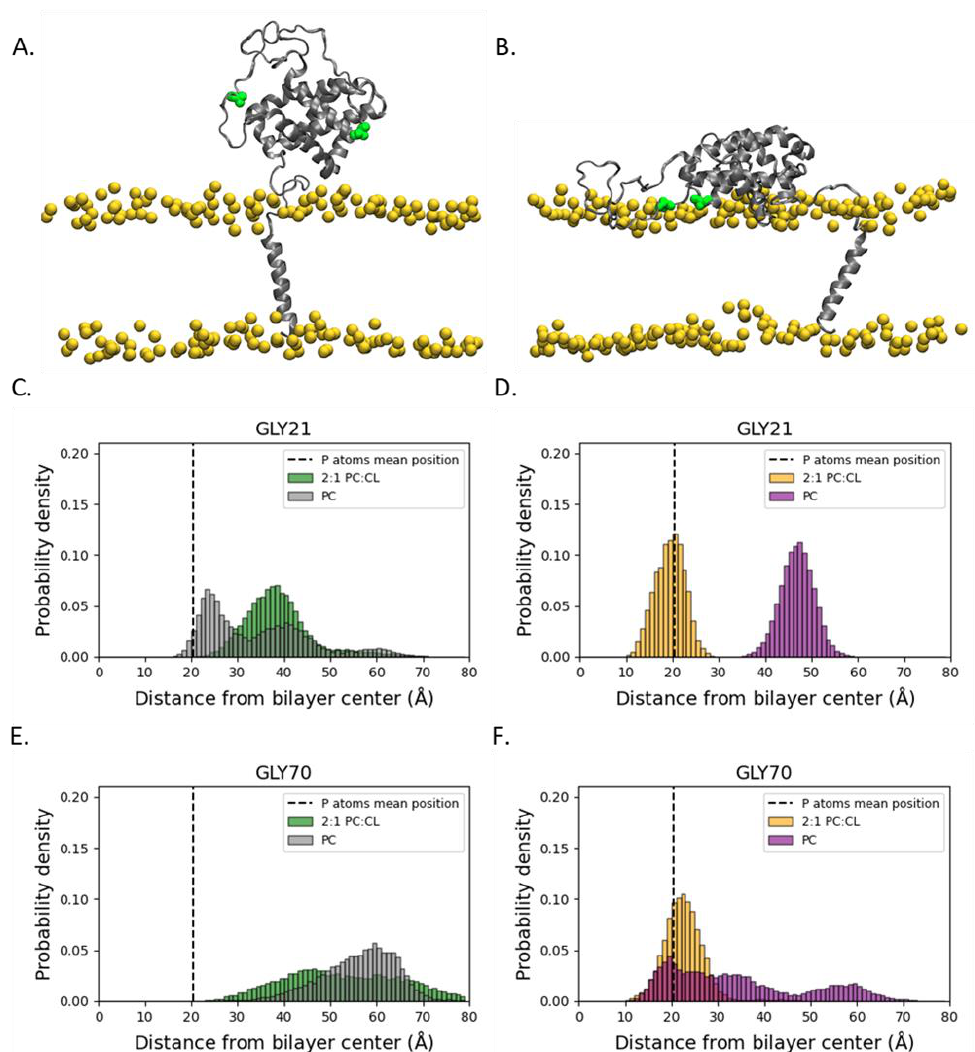
Figure 5. Interactions of the α1 - α2 loop with the membrane surface . ( A ) Configuration snapshot corresponding to a α1 - α2 loop that is not inter acting with the membrane surface in the unprotonated POPC:TOCL system. ( B ) Configuration snapshot corresponding to a membrane- interacting α1–α2 loop in the protonated POPC:TOCL system. The protein is shown in secondary structure representa- tion colored gray, while Gly-21 and Gly-70 are shown in green as filled-spheres. The lipid phosphate phosphorus atoms are shown as yellow spheres. The rest of the simulation system has been removed for clarity. ( C – F ). The distributions of two glycines in the α1 - α2 loop (Gl y- 21 near α1 and Gly -70 in the middle of the loop chain) along the transmembrane direction suggest that protonation of Bcl-xL promotes the interactions of the loop with the membrane surface, while the addition of cardiolipin favors the partitioning of the loop residues in the membrane lipid headgroup region. The vertical dashed line in the histograms is located at the mean position of lipid phosphate group phosphorus atoms, an indication of the location of the membrane lipid headgroup region along the transmem- brane direction.